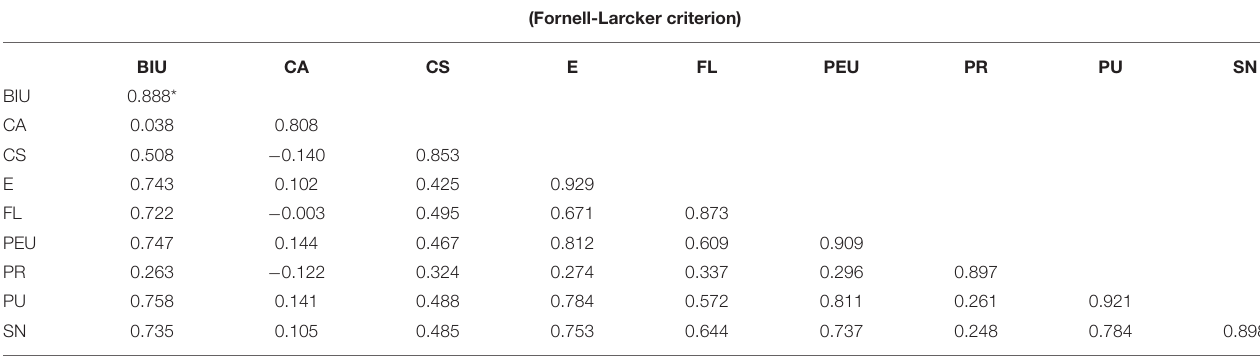
TABLE 4 | Discriminant validity (Fornell-Larcker criterion).